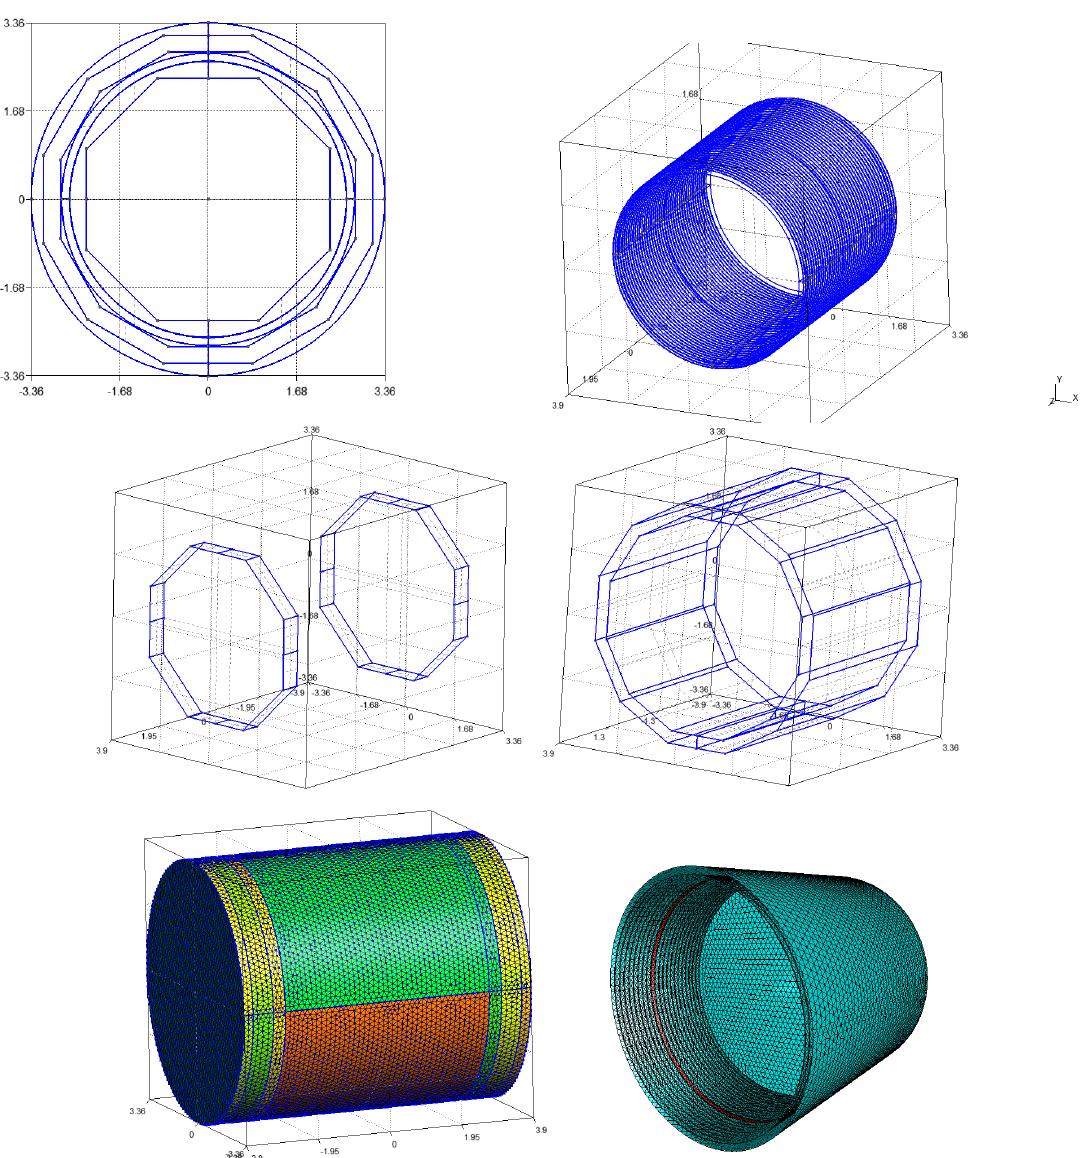
Figure A1. Images of the Gmsh model: (1) Cross section of entire geometry perpendicular to the z-axis. (2) Image of the TPC only with 10 cm wide voltage strips spaced by about 2.5 cm. (3) Twelve- sided Barrel ECAL only. (4) Two hexagonal end cap ECAL only. (5) 3D mesh of the pressure vessel produced by the Gmsh software. (6) Image of the dual-anode TPC produced by ElmerGUI. Red Circular ring is a single voltage